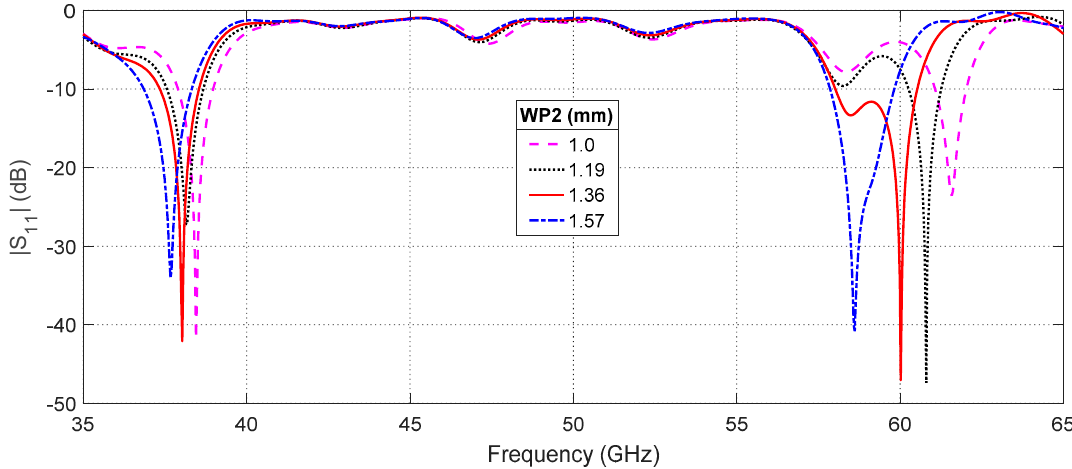
Figure 9. Changing the width of the second patch, WP 2 , leads to coarse tuning of the center frequency of the upper band ( 60 GHz ) and fine tuning of the center frequency of the lower band.